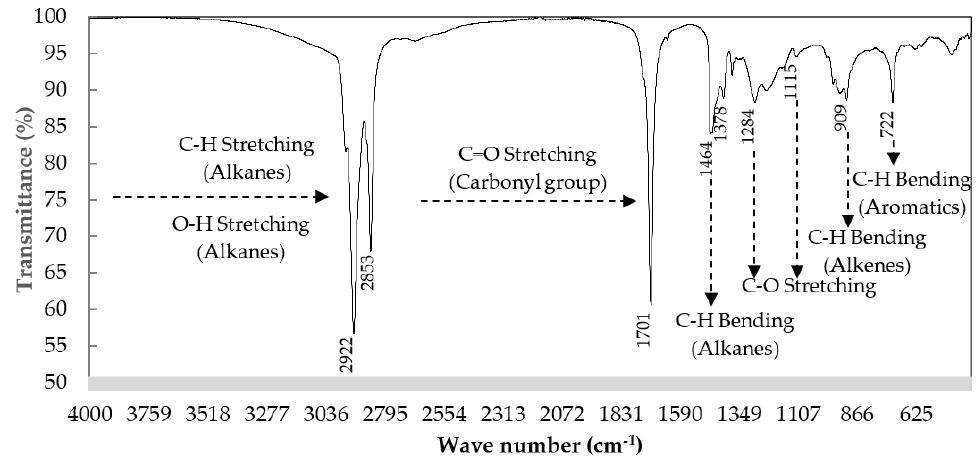
Figure 9. The FT–IR spectra of liquid bio-oil obtained at the optimum operating conditions.